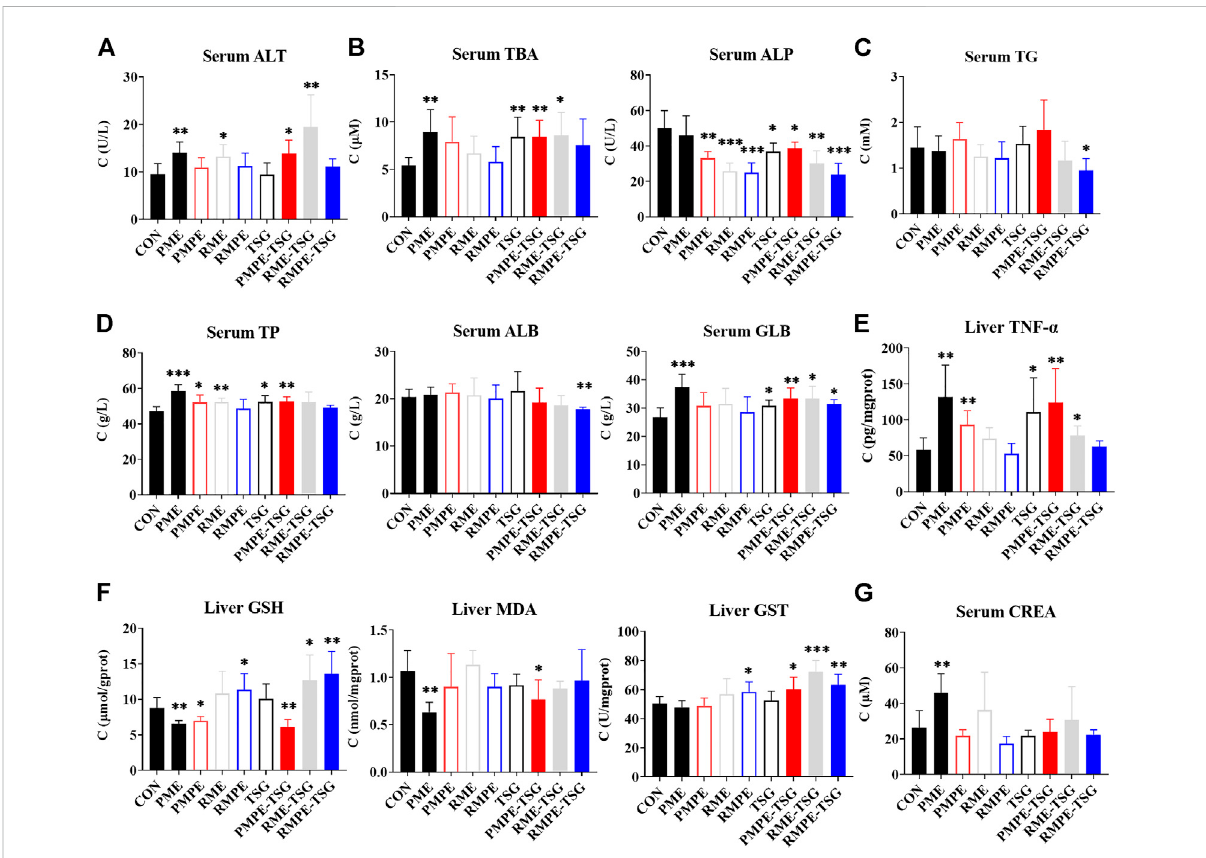
FIGURE 4 TheserumandintrahepaticbiochemicalindexesofeachgroupinthePMhepatotoxicitystudy.Datawereexpressedasmean±SD( n =6);Two- tailed independent Student ’ s t -test was conducted between each experimental group and the CON group. When p < 0.05, there was a statistical signi fi cance. *: p < 0.05; **: p < 0.01; ***: p < 0.001. (A) Hepatocyte membrane leakage index ALT, (B) Cholestasis index TBA and ALP, (C) Lipid metabolism index TG, (D) Protein synthesis function indexes TP and ALB and body in fl ammatory signaling GLB (equal to TP minus ALB), (E) In fl ammation index TNF- α (determined by enzyme-linked immunosorbent assay), (F) Oxidative stress index reduced GSH, MDA (lipid